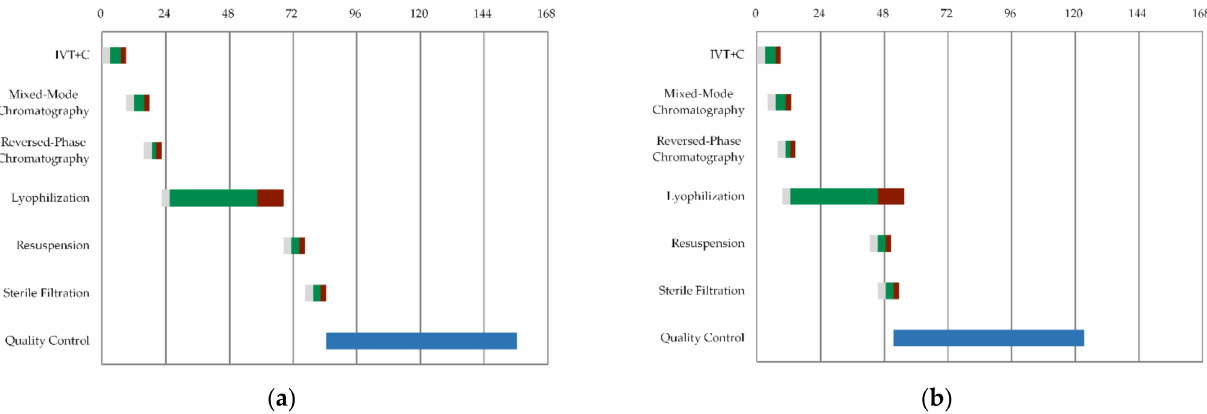
Figure 4. Batch mRNA production schedule. Scheduled with downtime between unit-operations due to preparation and CIP/SIP procedures ( a ) and with no processing downtime ( b ). Preparation (gray); Processing (green); CIP/SIP (dark red); Quality control